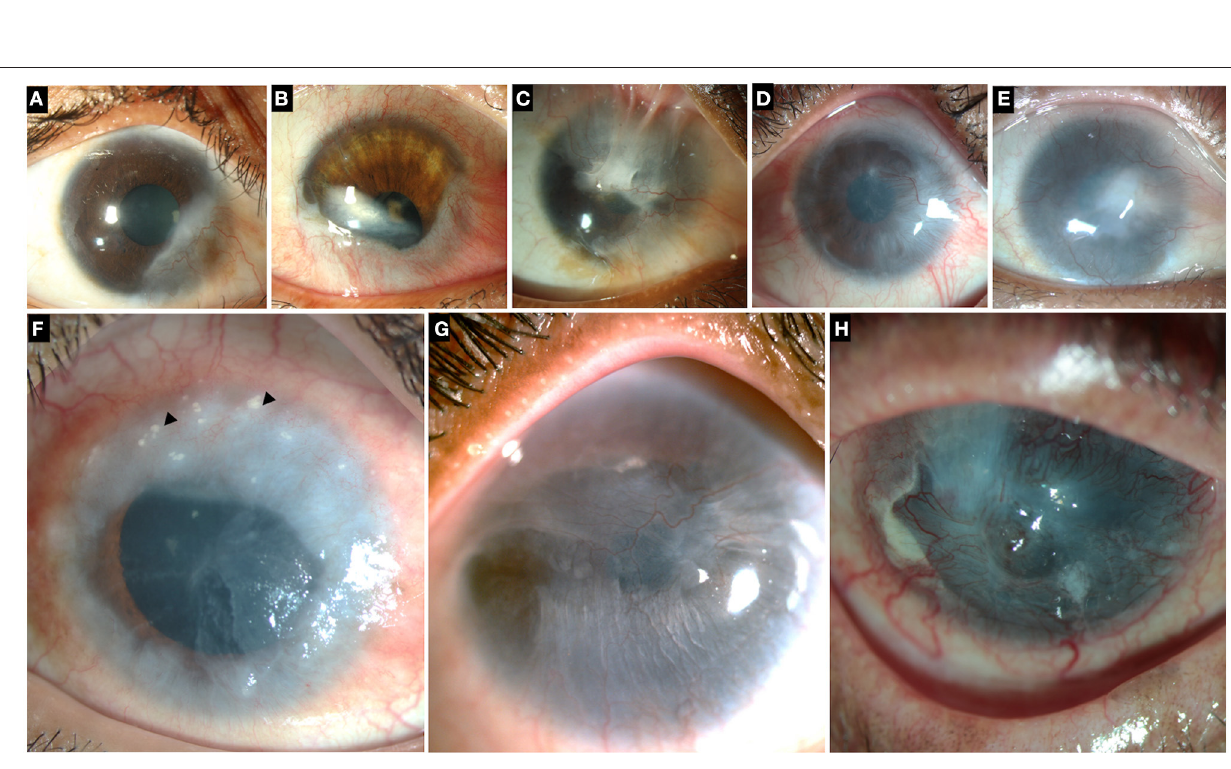
Frontiers in Medicine | www.frontiersin.org